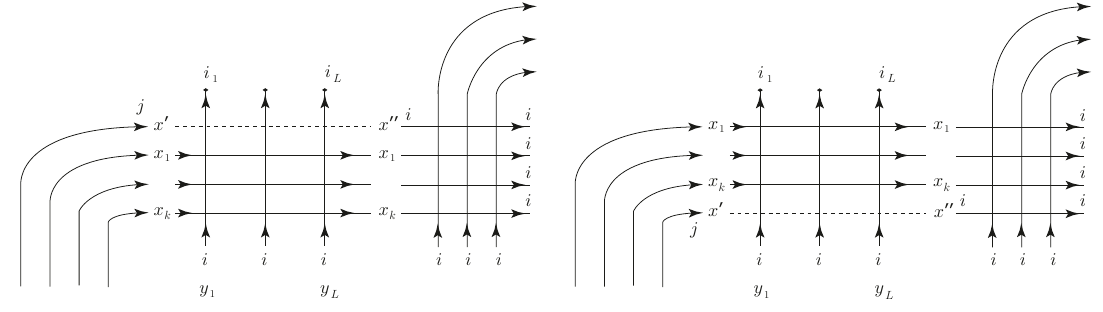
Figure 10 . Higgsed lattice configurations connected with other